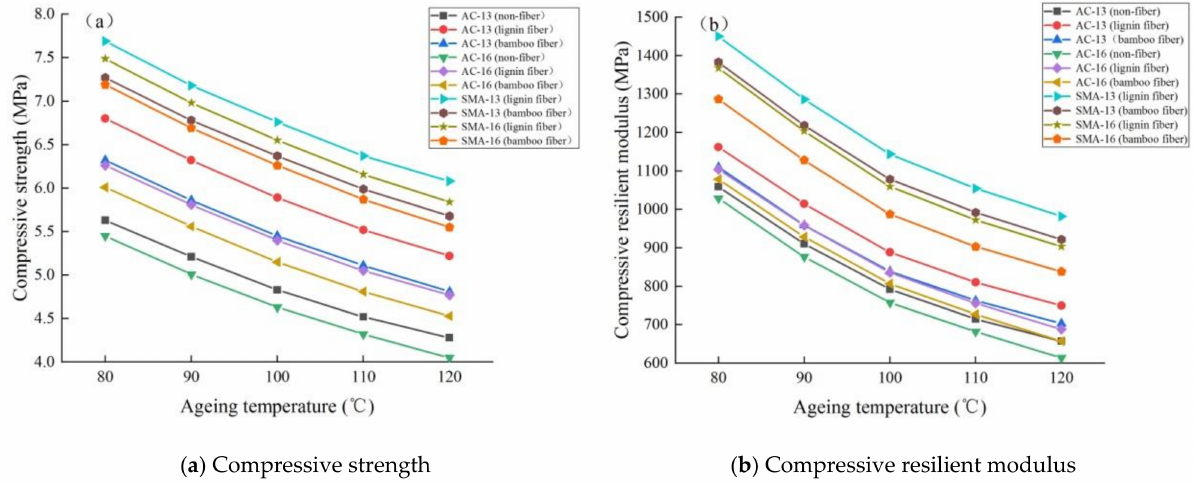
Figure 7. Test results of mechanical properties of fiber asphalt mixture under different ageing